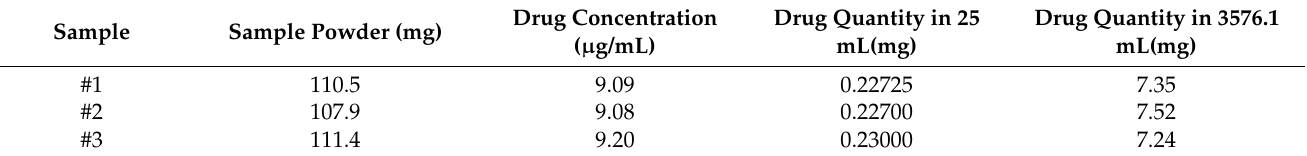
Table 7. Absolute amount of